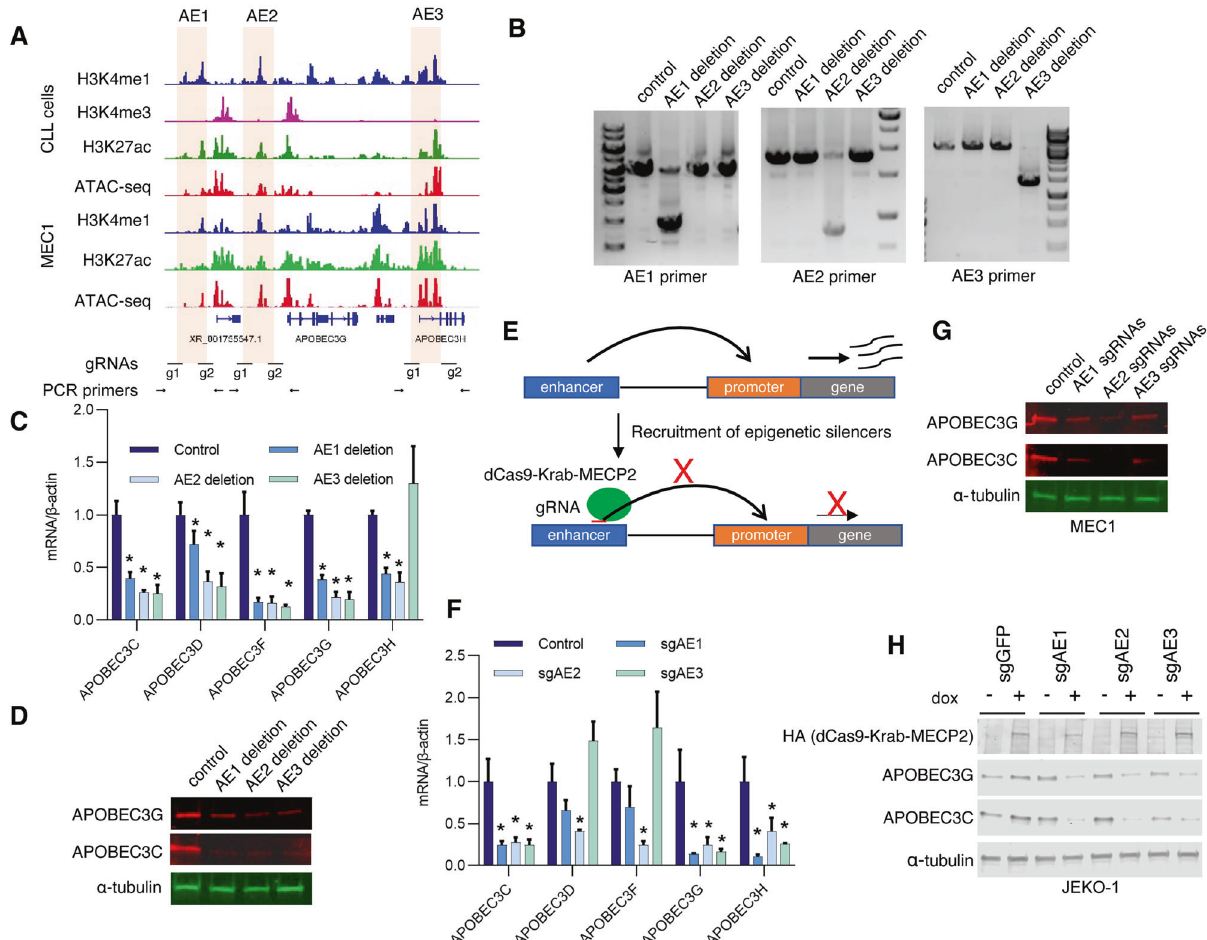
Fig. 3 Deletion or inhibition of APOBEC3 enhancers suppresses APOBEC3 expression. A Outline of the strategy to delete the AEs by CRISPR-Cas9. The genomic locus of the gRNAs to target the AEs and the PCR primers to amplify the enhancer regions were shown. B Gel imaging shows the successful deletion of AEs. The AE regions were ampli fi ed by PCR primers spanning the indicated regions as in panel ( A ). C RT-qPCR analysis of APOBEC3 expression in the AE-deleted MEC1 cells. n = 3 independent experiments. D Western blot analysis of APOBEC3C and APOBEC3G expression in the AEs deleted MEC1 cells. E Schematic view of the strategy of CRISPRi. MEC1 cells expressing dCas9-Krab-MECP2 were infected with sgRNAs targeting the indicated enhancer regions to suppress the enhancer activity. F RT-qPCR analysis of APOBEC3 expression after inhibition of individual AEs by CRISPRi. n = 3 independent experiments. The cells with infection of indicated sgRNAs were incubated with 0.25 μ g/ml doxycycline for 3 days to induce dCas9-Krab-MECP2 expression before the cells were harvested. G Western blot analysis of APOBEC3C and APOBEC3G expression after inhibition of individual AEs by CRISPRi in MEC1 cells. The cells with infection of indicated sgRNAs were incubated with 0.25 μ g/ml doxycycline for 3 days before the cells were harvested. H Western blot analysis of APOBEC3C and APOBEC3G expression after inhibition of individual AEs by CRISPRi in JEKO1 cells. The JEKO1 cells with dCas9-Krab-MECP2 infected with indicated sgRNAs were incubated with or without 0.25 μ g/ml doxycycline for 3 days before the cells were harvested. In the AEs deletion and CRISPRi assays, gRNA targeting GFP is used as a